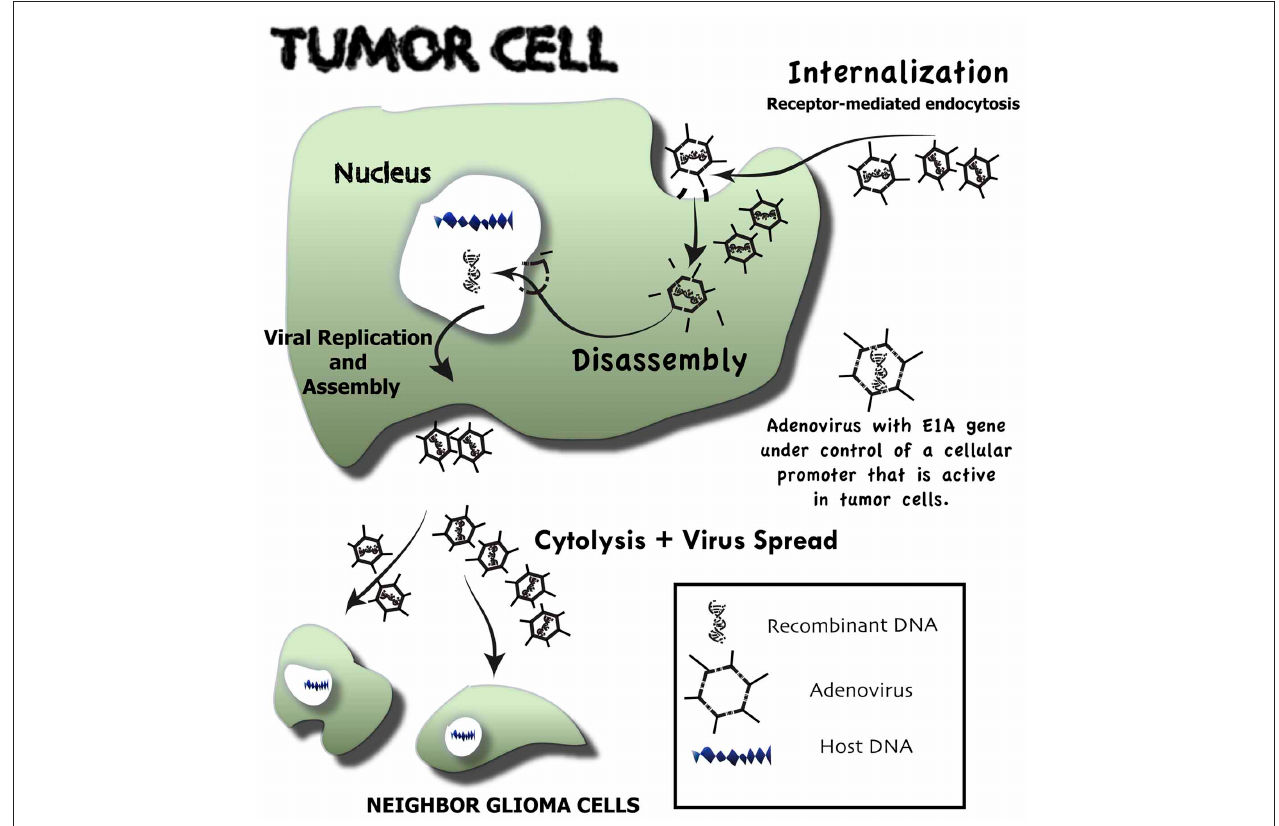
FIGURE 1 | Overview of the events that follow upon conditionally replicative adenovirus infection of malignant glioma cells—oncolytic virotherapy. Neoplastic cells through a receptor-mediated endocytosis selectively internalize genetically engineered conditionally replicative adenoviruses (CRAds). These CRAds are tumor-selective because their E1A gene is under control of a cellular promoter that is active only in tumor cells. Following internalization, CRAds are engulfed by endosomes, where vectors